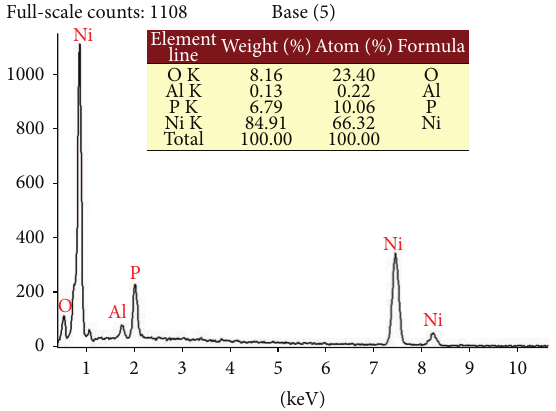
Figure 21: EDX diffractogram showing the % of elements present on the EN-coated Mg sample with 0.5% nano-Al 2 O 3 .